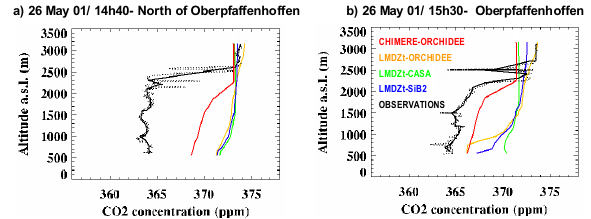
Fig. 2. Comparison between observed and modeled profiles for 2 case studies during the CAATER 1